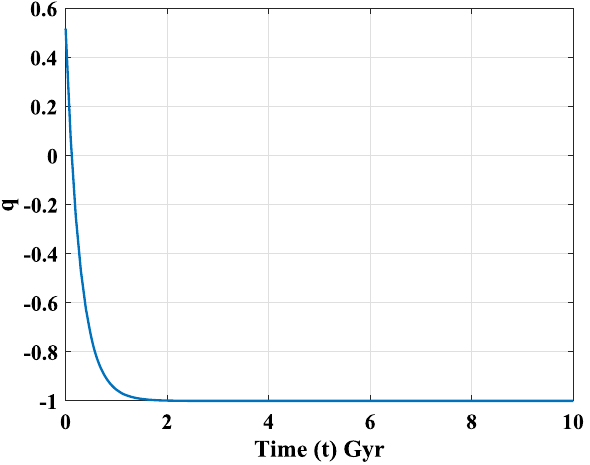
Fig. 14 Plot of v 2 s versus time ( t ) for k = 1 . 9, α 1 = 1 . 2, α 2 = 0 . 52, and γ 1 = 101